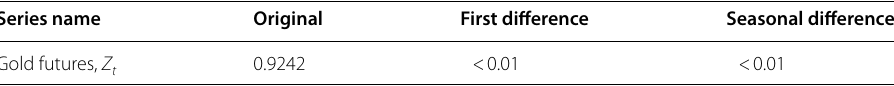
Table 1 Unit root test P-values for gold futures price